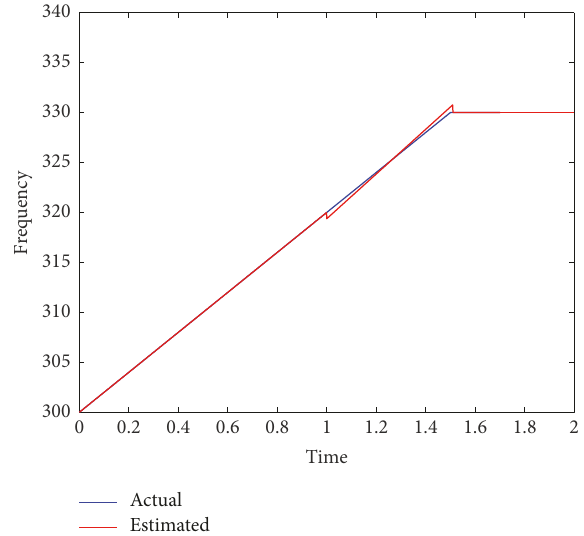
Figure 3: The simulated gear vibration signal with noise.